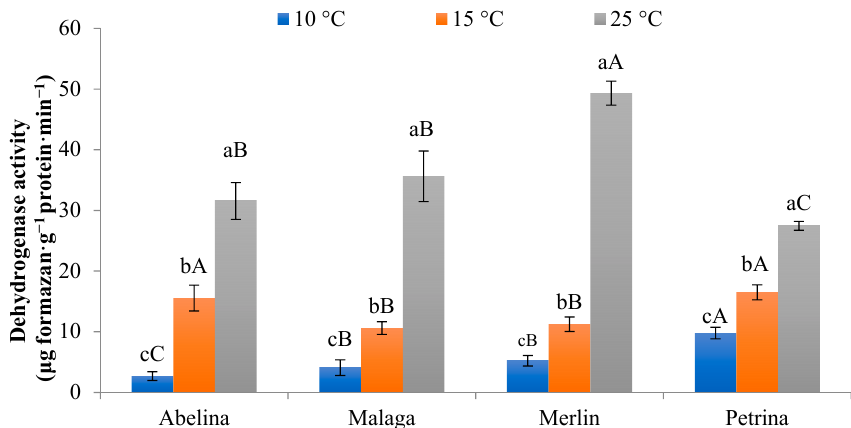
Figure 2. Dehydrogenase activity ( µ g formazan g − 1 protein min − 1 ) in the seeds of four soybean cultivars germinated at different temperatures. Values represent means ( n = 5) ± SE. The values for each cultivar followed by the same lowercase letter do not differ significantly, while means for the same temperature marked with the same uppercase letter do not differ significantly according to Duncan’s multiple range test ( p < 0.05).